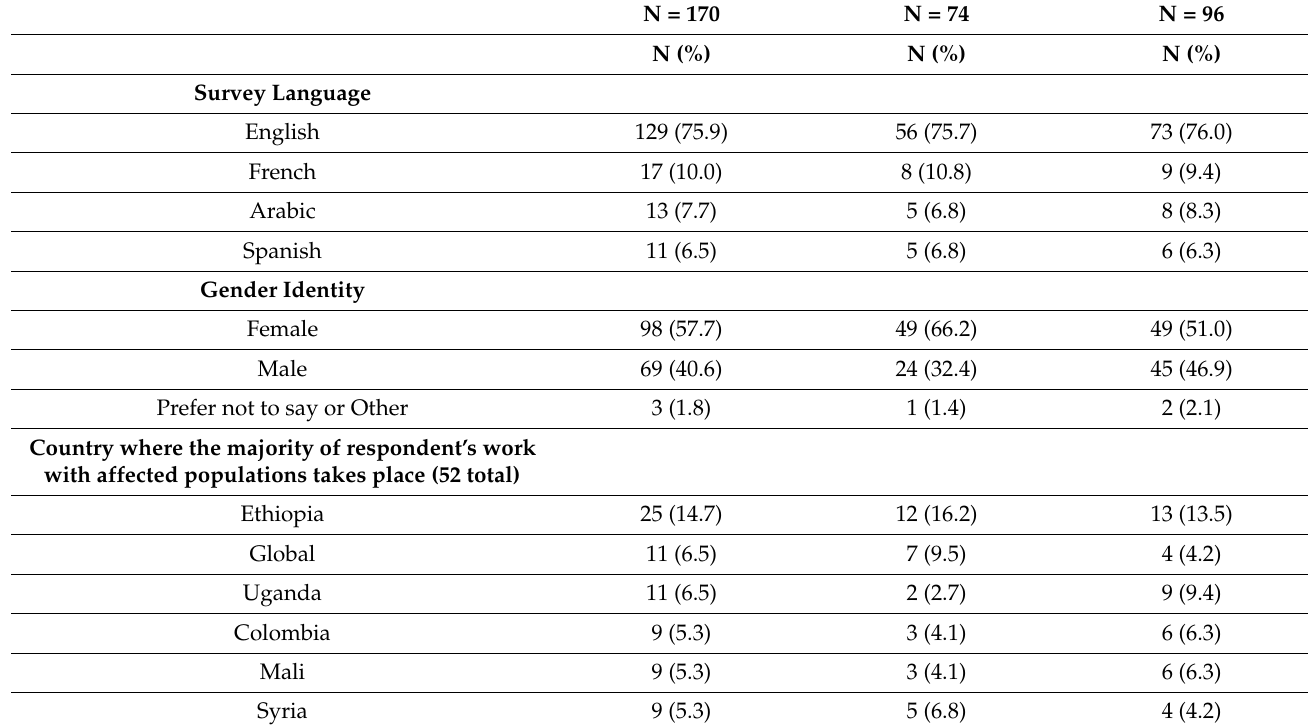
Table 2. Demographic and employment characteristics of humanitarian practitioners in the study